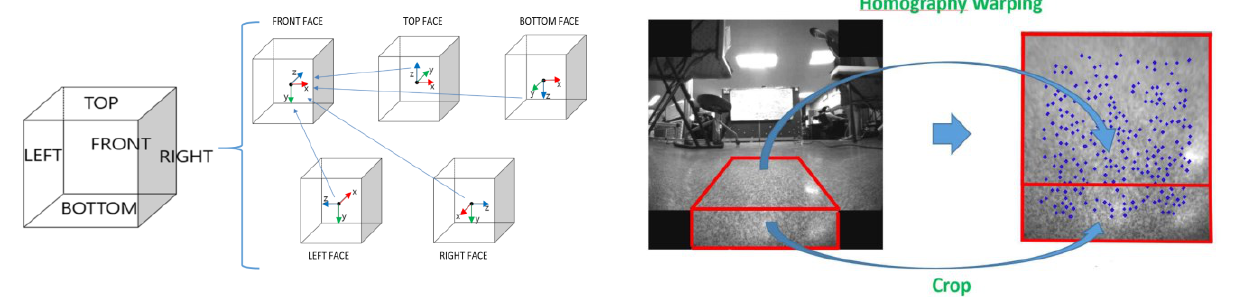
Figure 4 . Illustration of Cubemap Model.